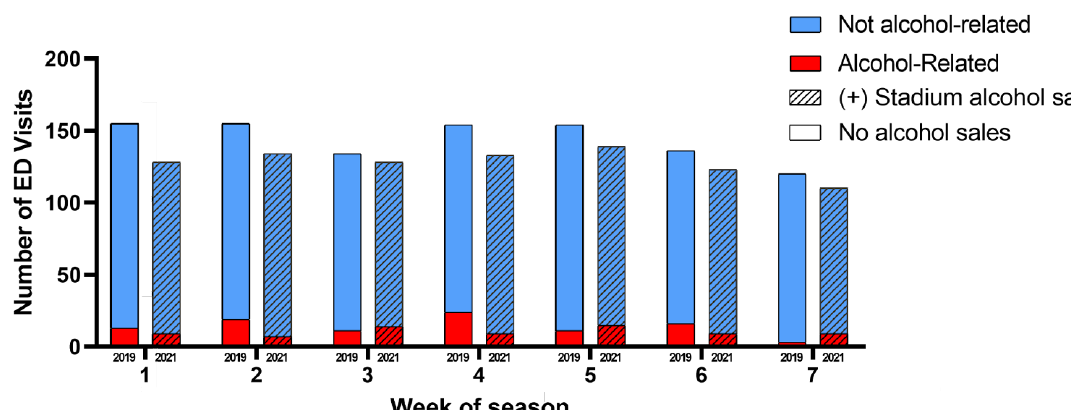
Figure 2. Number of emergency department (ED) visits on home game days, 2019 and 2021